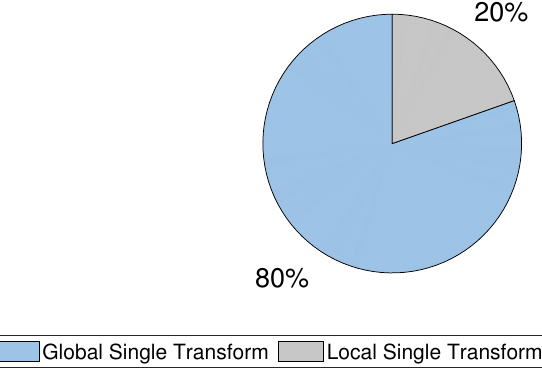
Figure 9. Most used feature